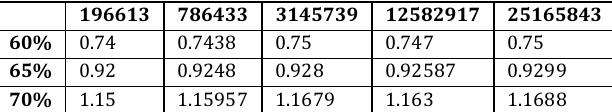
Table 4: Amortized #write, Murur, linear probing, str length=13